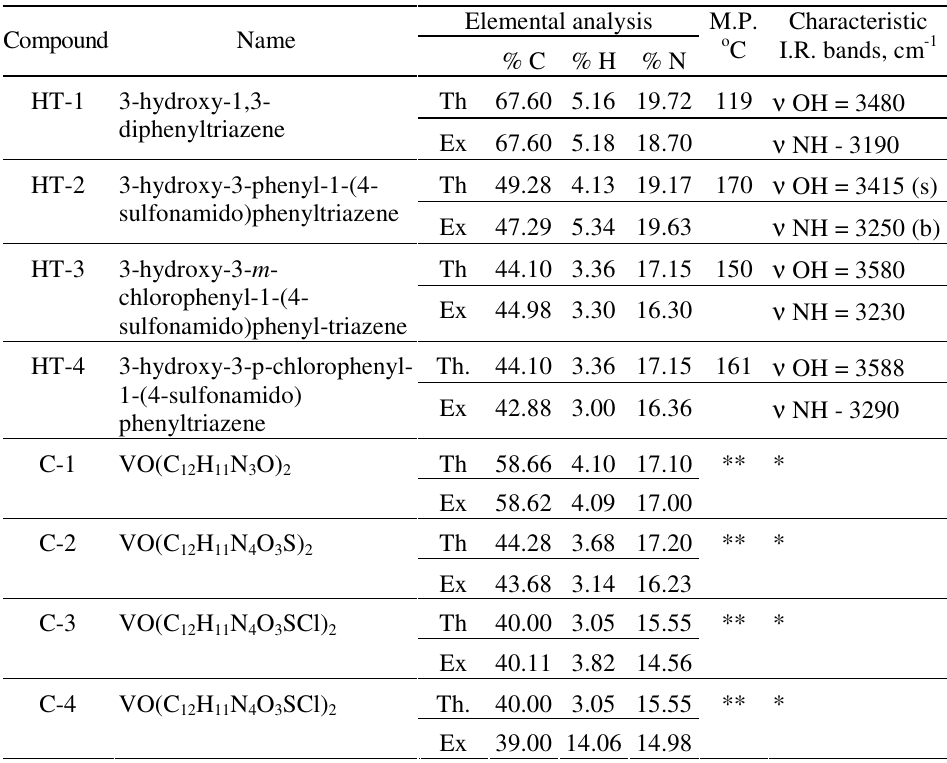
Table 1. Physical characteristics data of the test compounds.